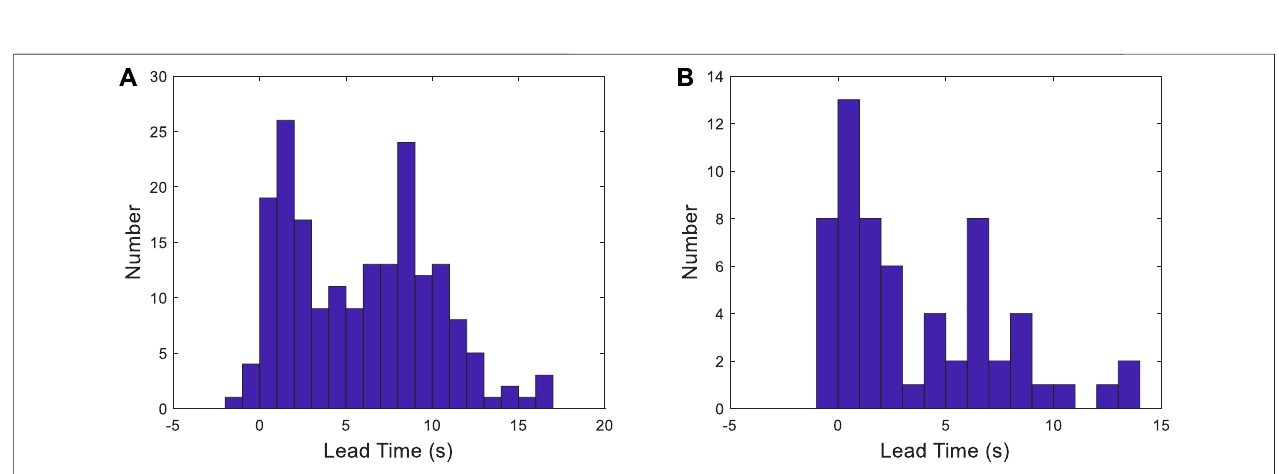
FIGURE 13 | Lead time distribution of the (A) Meinong data set, and (B) Hualien data set.